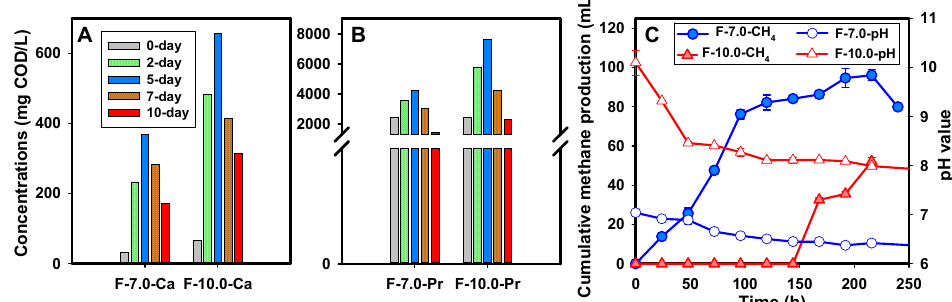
Figure 3. Performance of FSF hydrolysis and methane inhibition, ( A ) for soluble polysaccharides release; ( B ) for soluble protein release under alkaline condition; ( C ) for changes in cumulative methane production and pH value (Note: Error bars represent standard deviation).